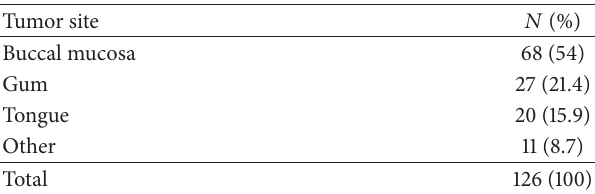
Table 2: Tumor distribution in the oral cavity.